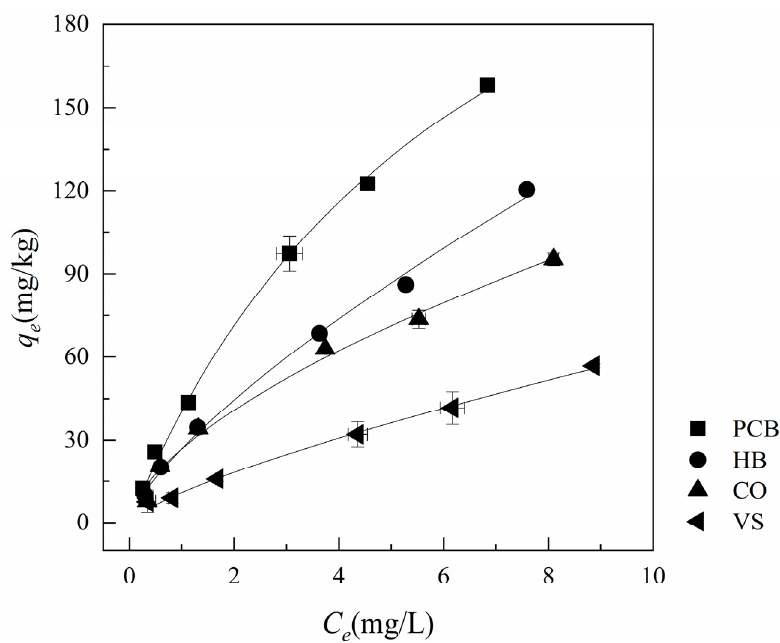
Figure 5. Ammonium adsorption isotherms of DW rinsed additive fillers (PCB, HB, CO and VS).